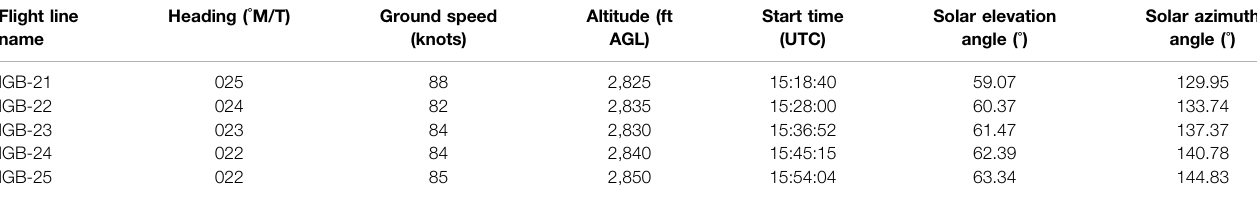
TABLE 1 | Details of the fi ve CASI-1500 fl ight lines acquired over Îles-de-Boucherville National Park on July 8,